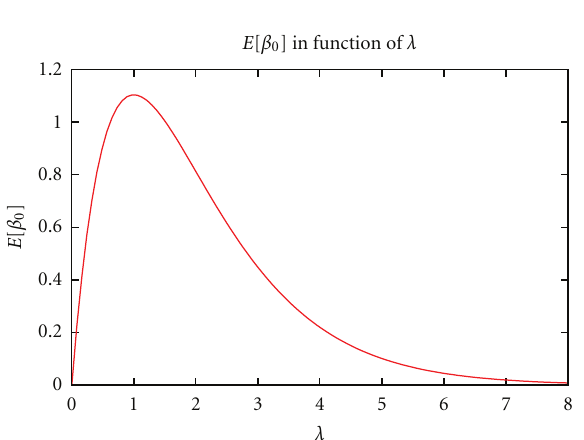
Figure 5: Variation of the mean number of clusters in function of λ when L (cid:6) 4 and (cid:4) (cid:6)